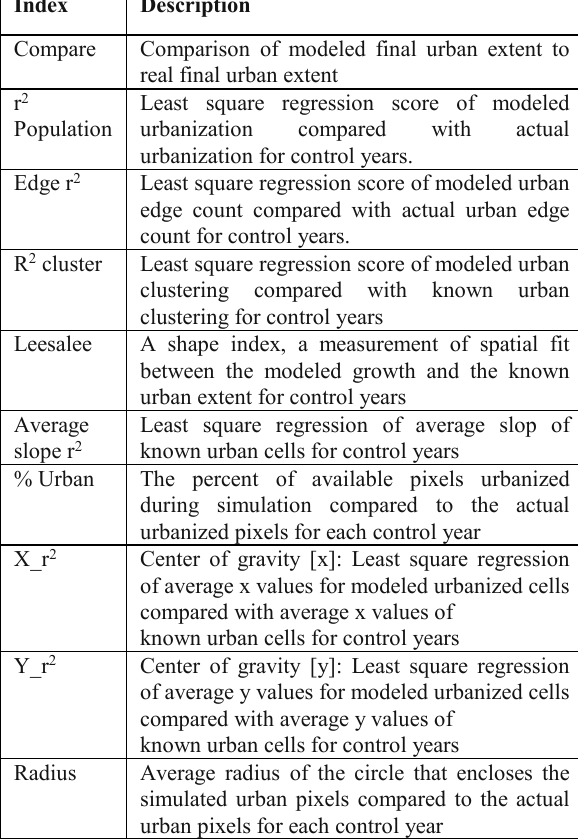
Table 1. Indices for evaluation of the calibration results in the SLEUTH modelling (Silva and Clarke, 2002)